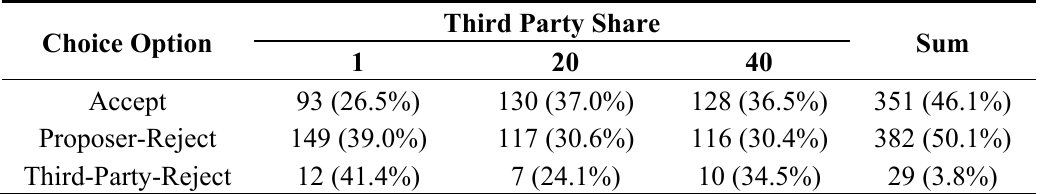
Table 2. Number and percentage of choices by third party share (Study 1; Percentages in columns ‘1’, ‘20’ and ‘40’ are row percentages per third party share; percentages in column ‘Sum’ are column percentages across choice